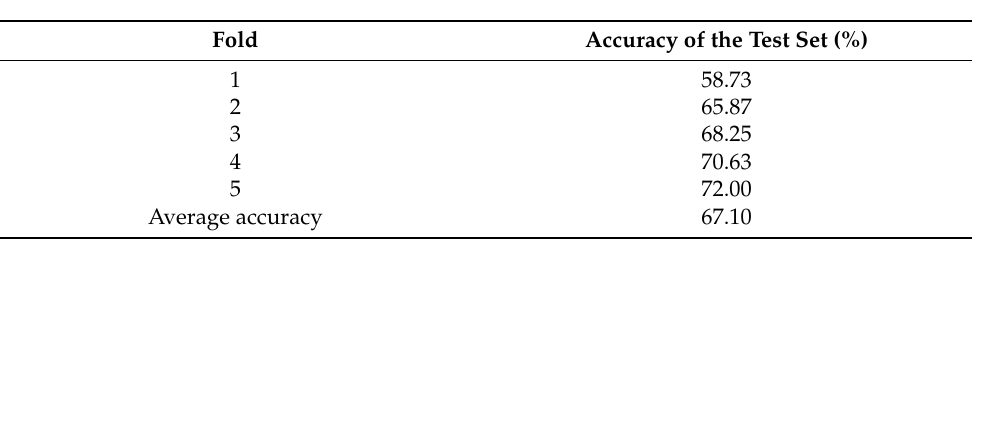
Figure 7. Accuracy and loss of the model including two hidden layers and 60 nodes in each layer on the training set. Table 4. Accuracy of the model including two hidden layer and 60 nodes tested with the available test set